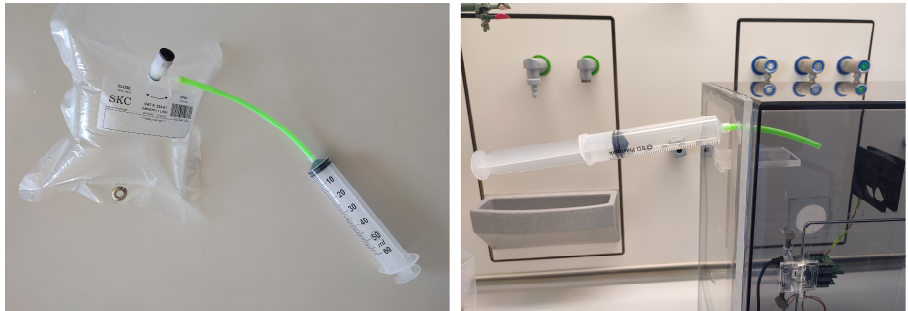
Figure 6. Small volume gas sample testing <1 L.